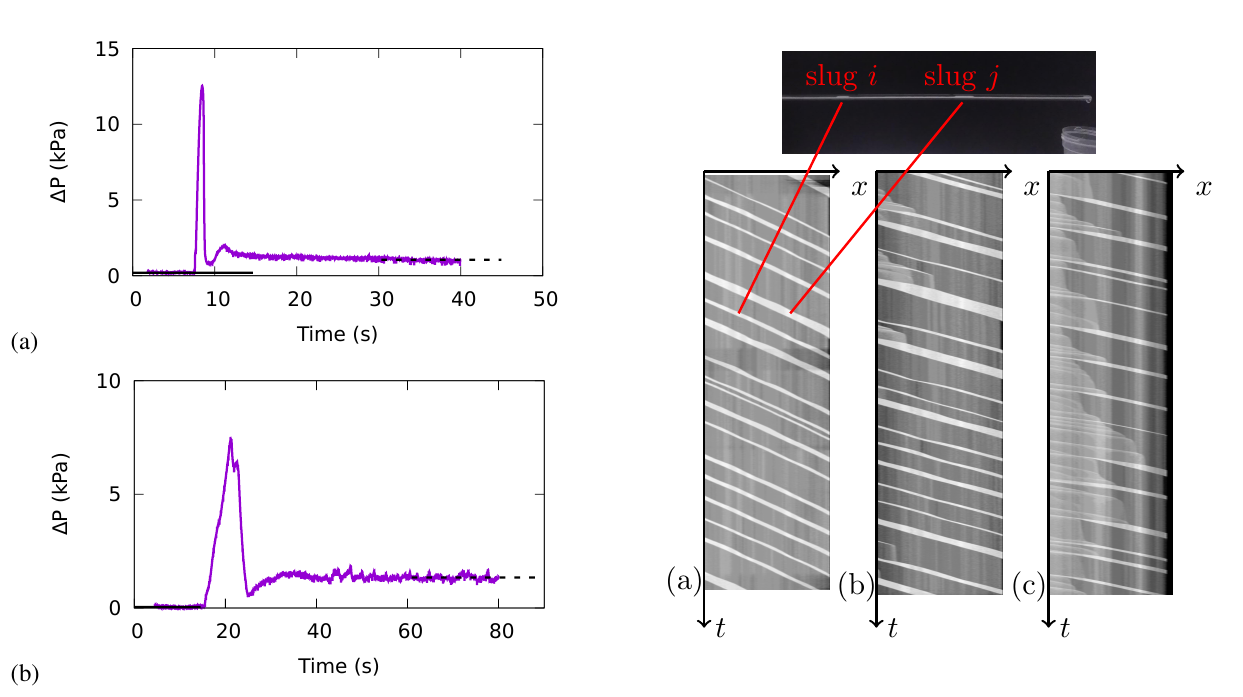
Figure 2. Pressure time series measured with an imposed flow rate (a) I 0 = 10 mL.min − 1 and (b) I 0 = 2 mL.min − 1 . Solid and dashed lines mark the steady pressure plateaus obtained without any grains.